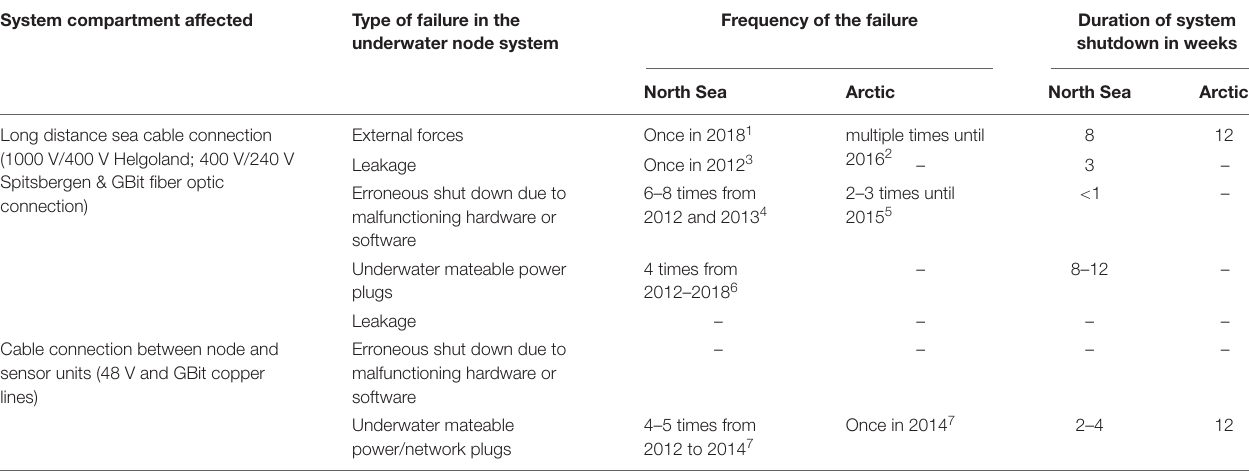
TABLE 1 | Summary of failures of the underwater nodes in the southern North Sea and in the